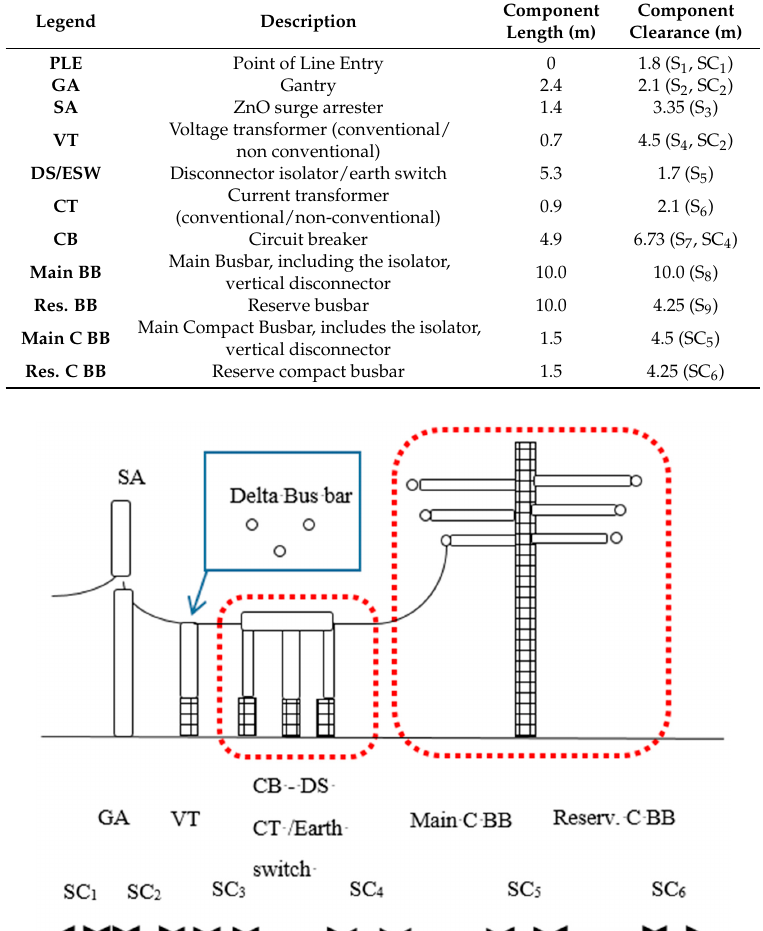
Table 5. Length and area reduction of a compact bay.